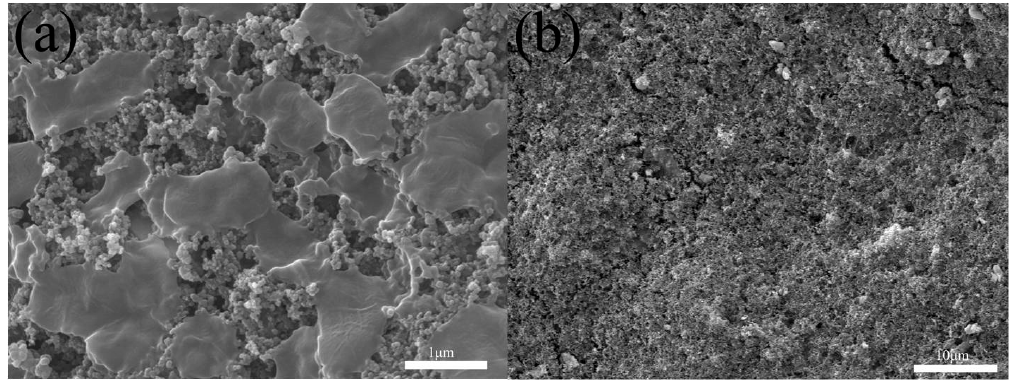
Figure 12. FESEM images of the OMC-CS electrode after the CDI process ( a ) and the regeneration process ( b ).